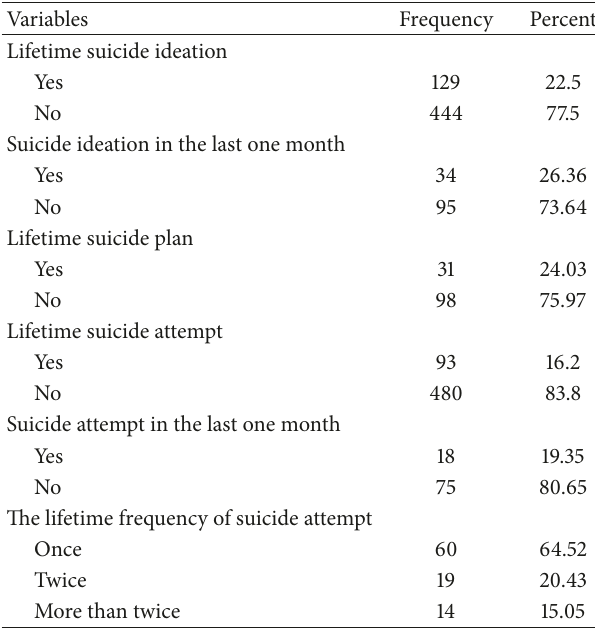
Table 4: Frequency distribution of suicide ideation and attempt among adolescent high school students in Dangila Town, Northwest Ethiopia